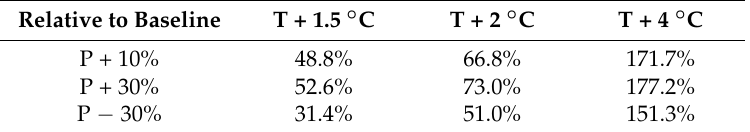
Table 6. Runoff change under combinations of temperature and precipitation variation scenarios.